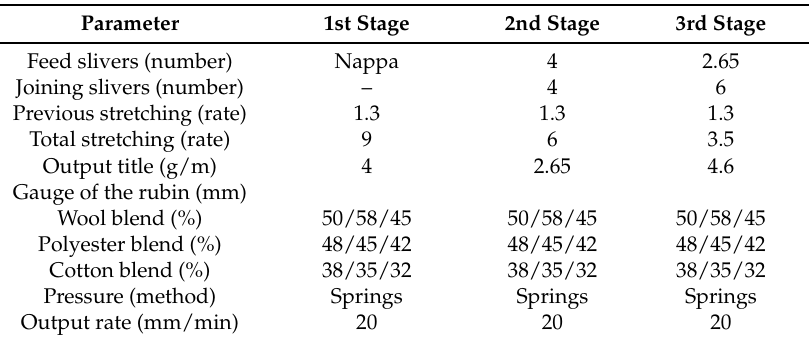
Figure 7. Veil of banana-wool blend 70/30. Table 7. Conditions for drawing frame the blends with banana fibers.